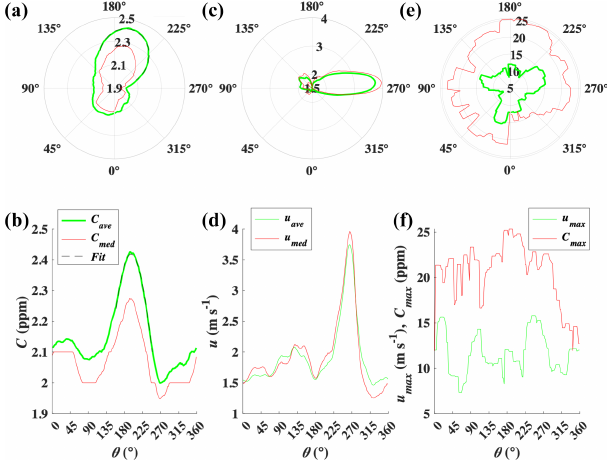
Figure 4. (a, b) Concentration, C , versus wind direction, θ , 1990– 2021 for average, C ave (θ) , and median, C med (θ) , and fit to C ave (θ) for 155 <θ < 250 ◦ . Data key is shown in panel (b) . (c, d) Wind speed, u , average, u ave (θ) , and median, u med (θ) . Data key is shown in panel (d) . (e, f) Maximum C , C max (θ) , and wind speed, u max (θ) . Data key is shown in panel (f) . Polar plot oriented as at WCS facing the COP seep